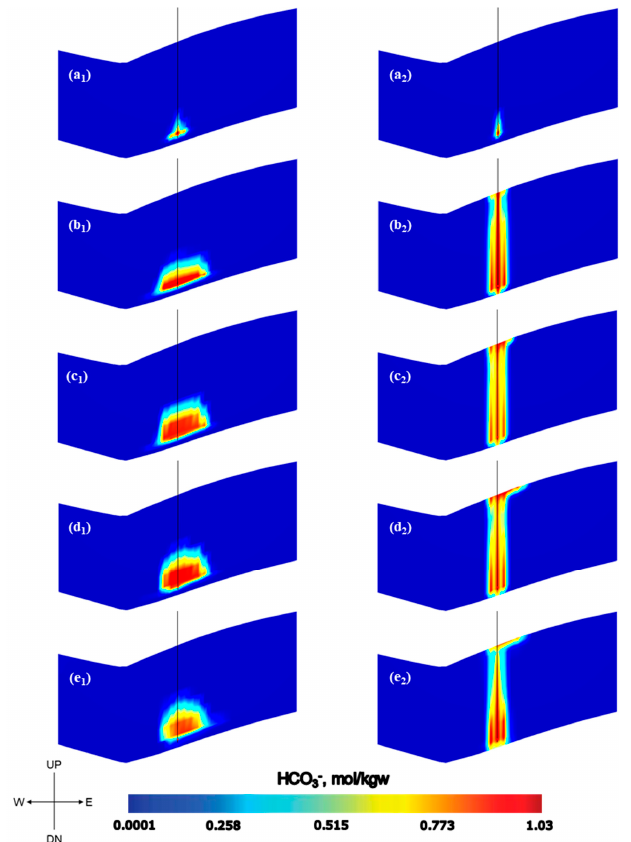
Figure 5. Fence diagrams of simulated HCO 3 − concentration (mol/kgw) evolution for the base case ( a 1 , b 1 , c 1 , d 1 , e 1 ) and homogeneous case ( a 2 , b 2 , c 2 , d 2 , e 2 ) at ( a ) 1 year, ( b ) 30 years, ( c ) 100 years, ( d ) 1000 years, and ( e ) 10,000 years. Each figure’s size is approximately 35 km × 550 m (x, z).